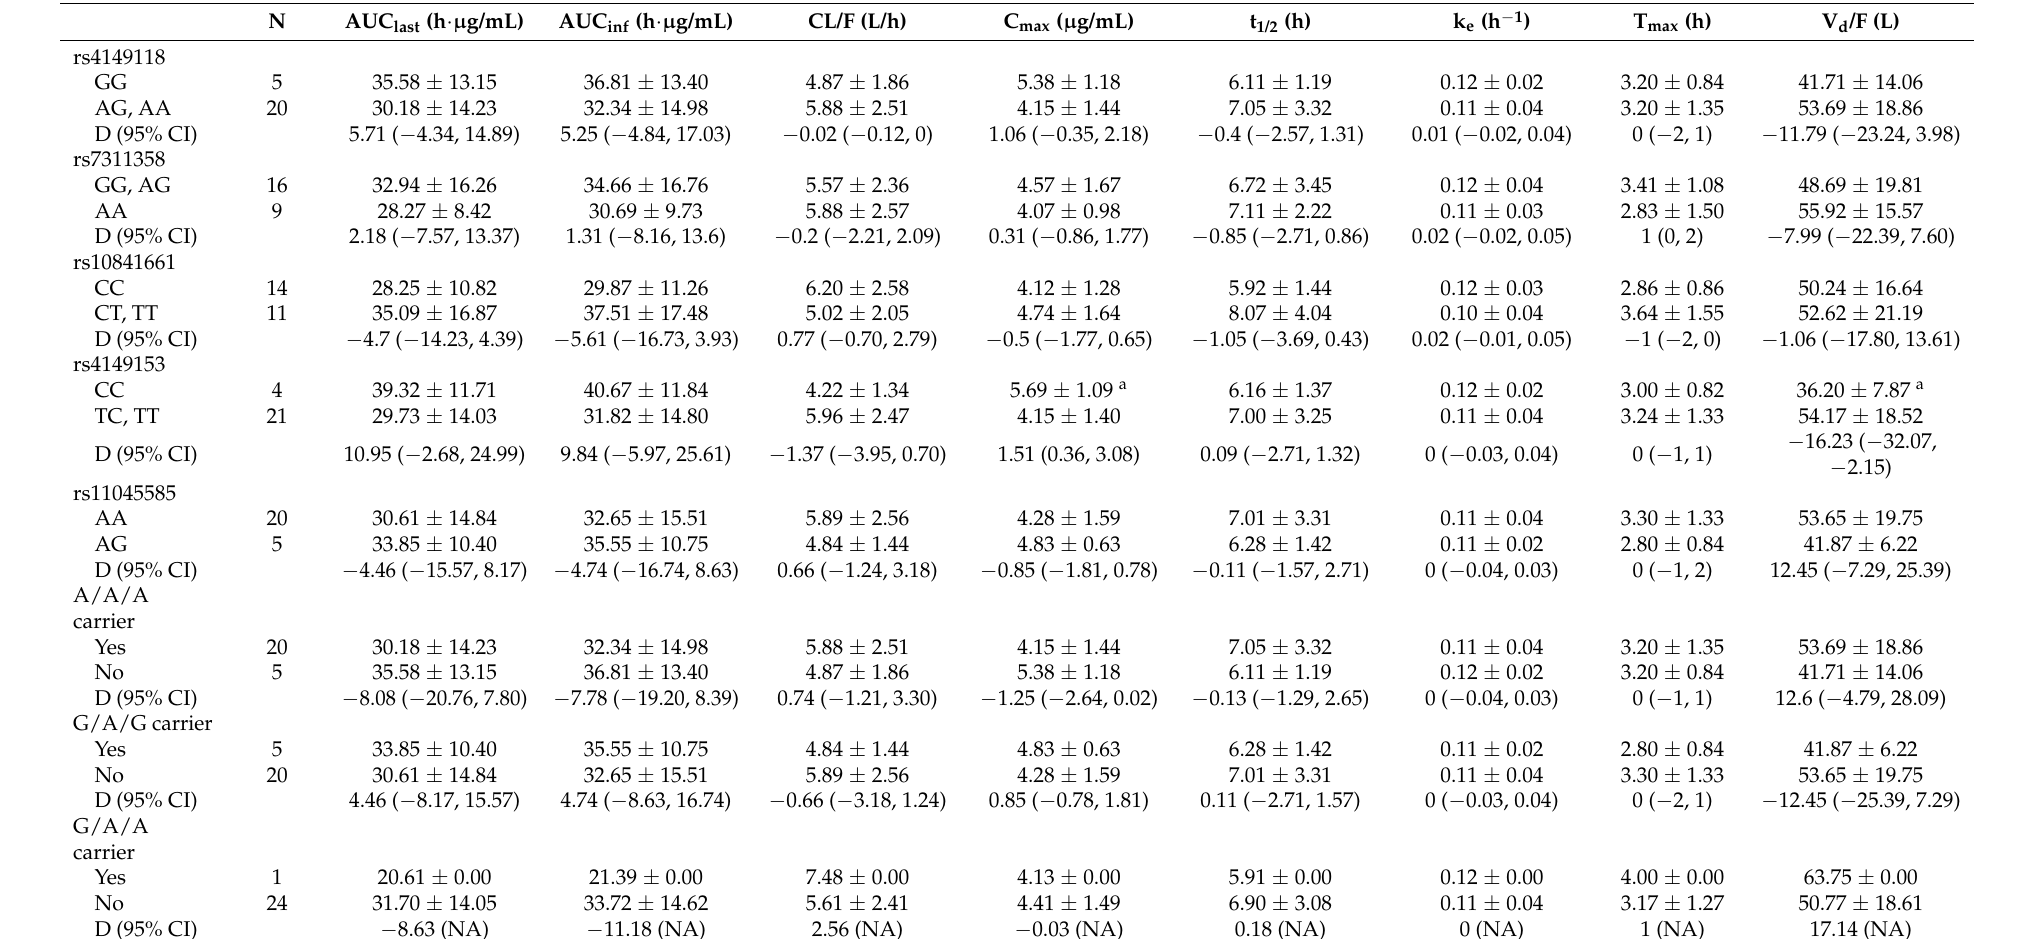
Table 3. Effects of SLCO1B3 polymorphisms on valsartan